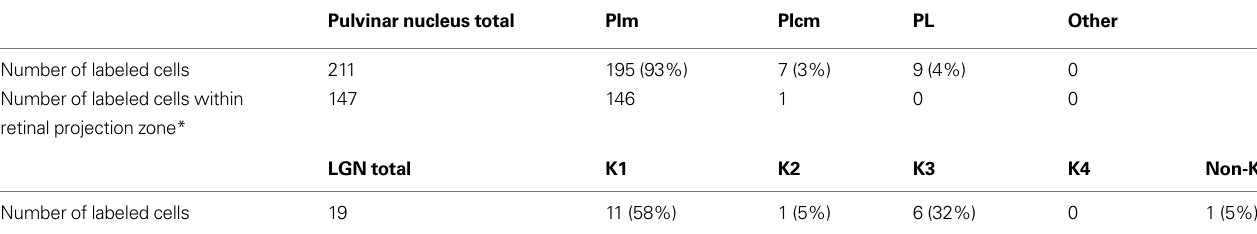
Table 2 | Distribution of fast blue labeled cells in the pulvinar nucleus and LGN ^